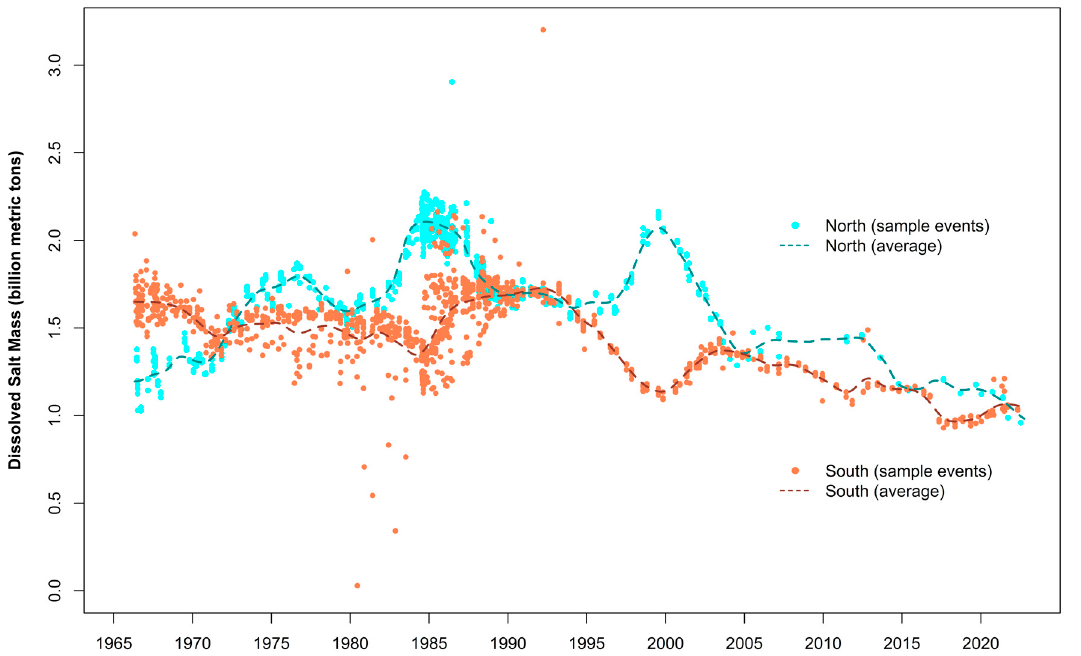
Figure 7. North and south arm average dissolved salt mass over the period of record at GSL measurement sites (Figure 1). Point values were calculated using all measurements at a single site on a given date. Dashed lines represent the estimated monthly time series.